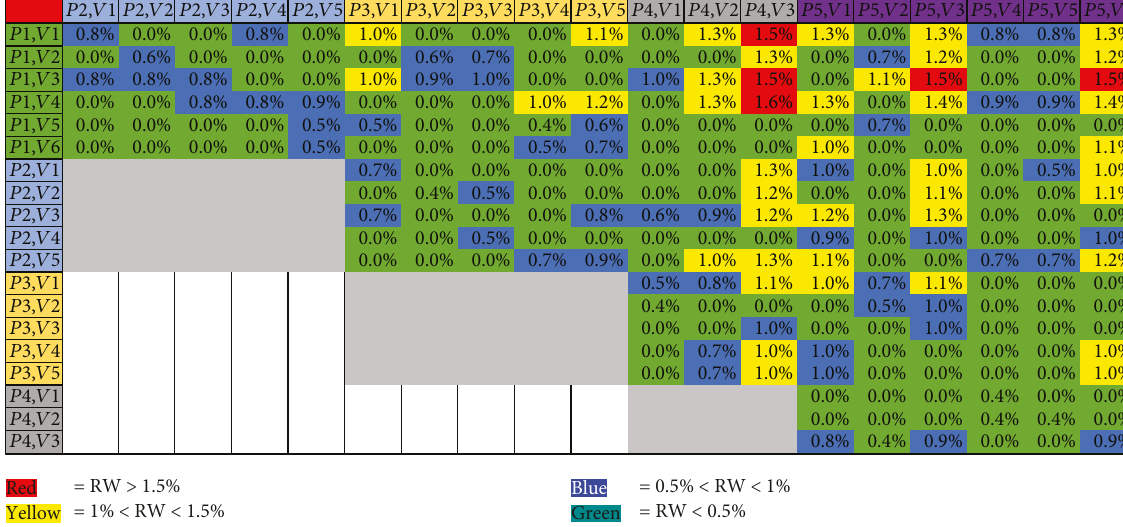
Figure 9: Colour-coded relative weight (RW) of element